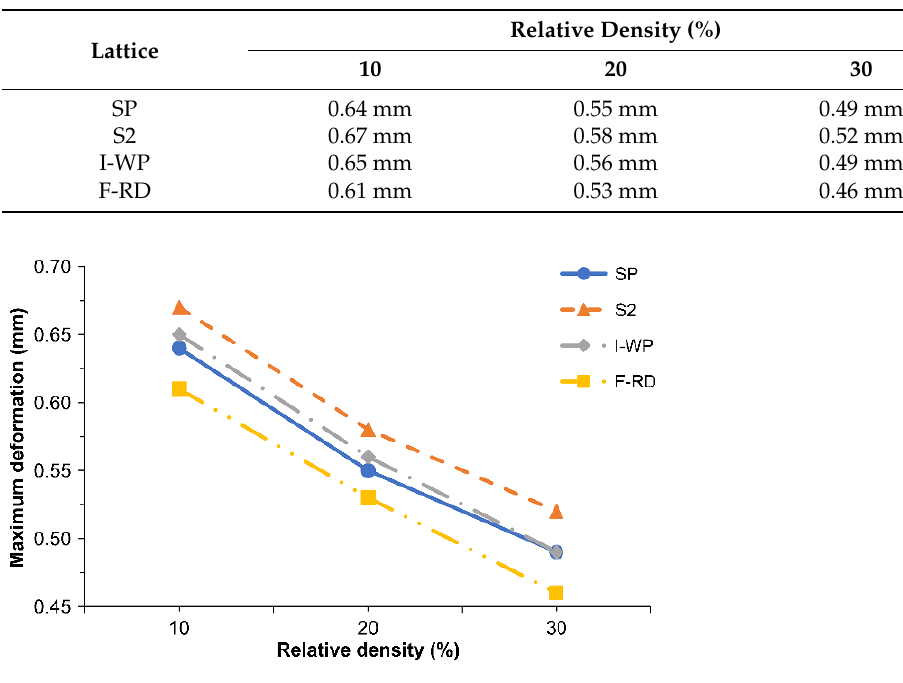
Figure 11. Z -axis deformations of SPSs with different TPMS lattice cores. Table 9. Linear approximations of the deformation.